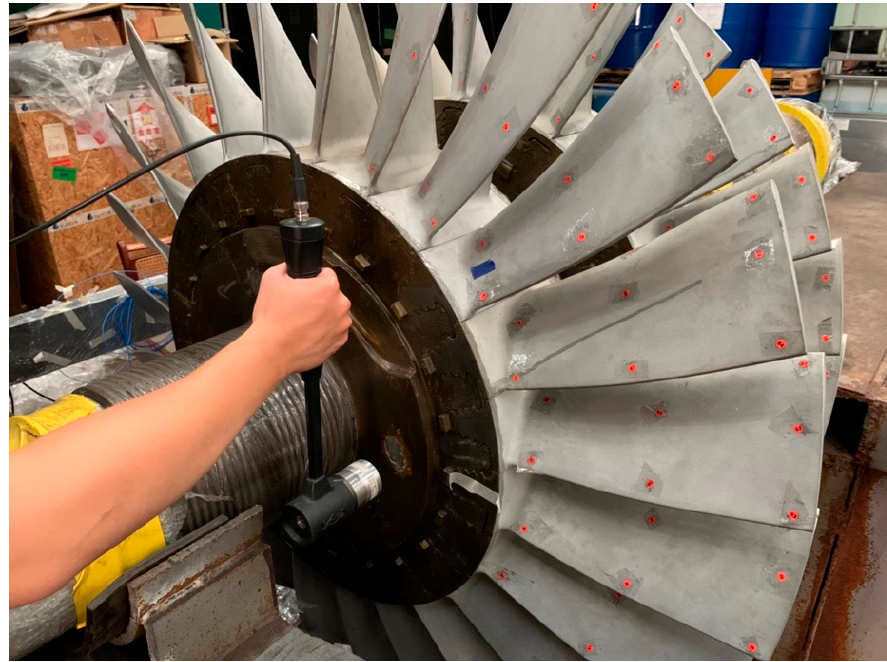
Figure 9. A typical X direction and the clock position of three o’clock meaning directly to the right of the excitation applied in modal testing of in-situ measurements. the excitation applied in modal testing of in-situ